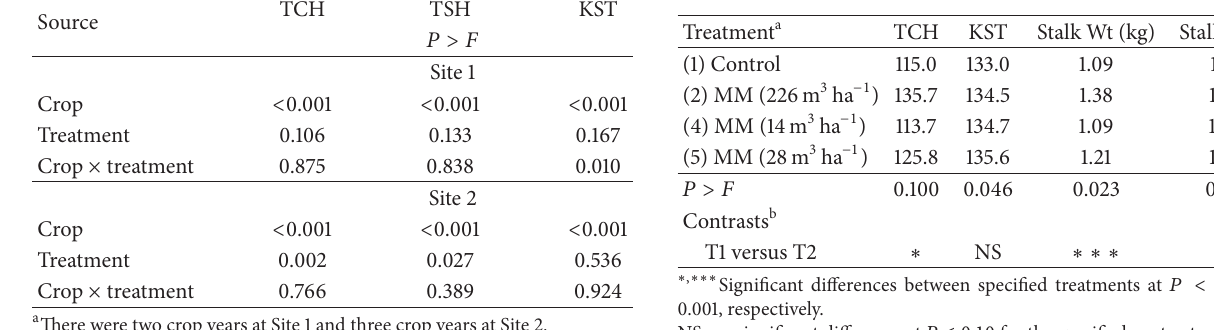
Table 4: Predicted least squares means and 𝑃 > 𝐹 for yield (KST) for the plant cane crop at Site 1. Also included are significant contrasts.